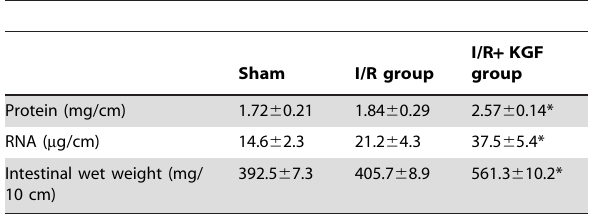
Table 2. Intestinal wet weight and contents of jejunal protein and RNA # .